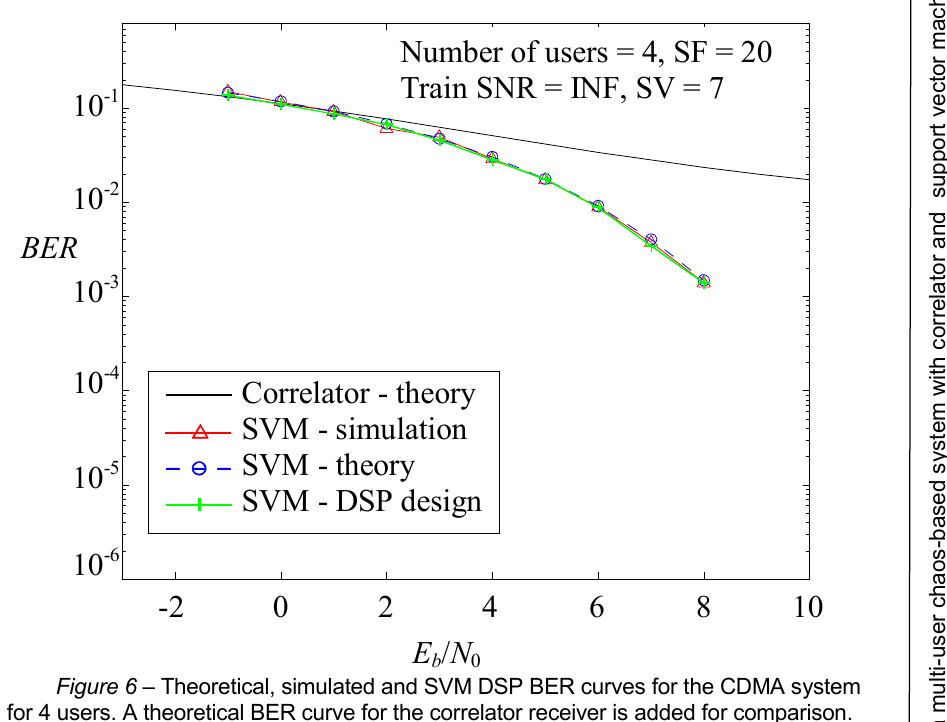
Figure 6 – Theoretical, simulated and SVM DSP BER curves for the CDMA system for 4 users. A theoretical BER curve for the correlator receiver is added for comparison. Рис . 6 – Кривые вероятности битовой ошибки (BER), полученные при теоретическом моделировании и DSP результатах для систем CDMA и SVM с четырьмя пользователями . Теоретическая BER кривая корреляционного приемника приведена для сравнения Slika 6 – Grafovi verovatno ć e greške bita (BER) dobijeni prema